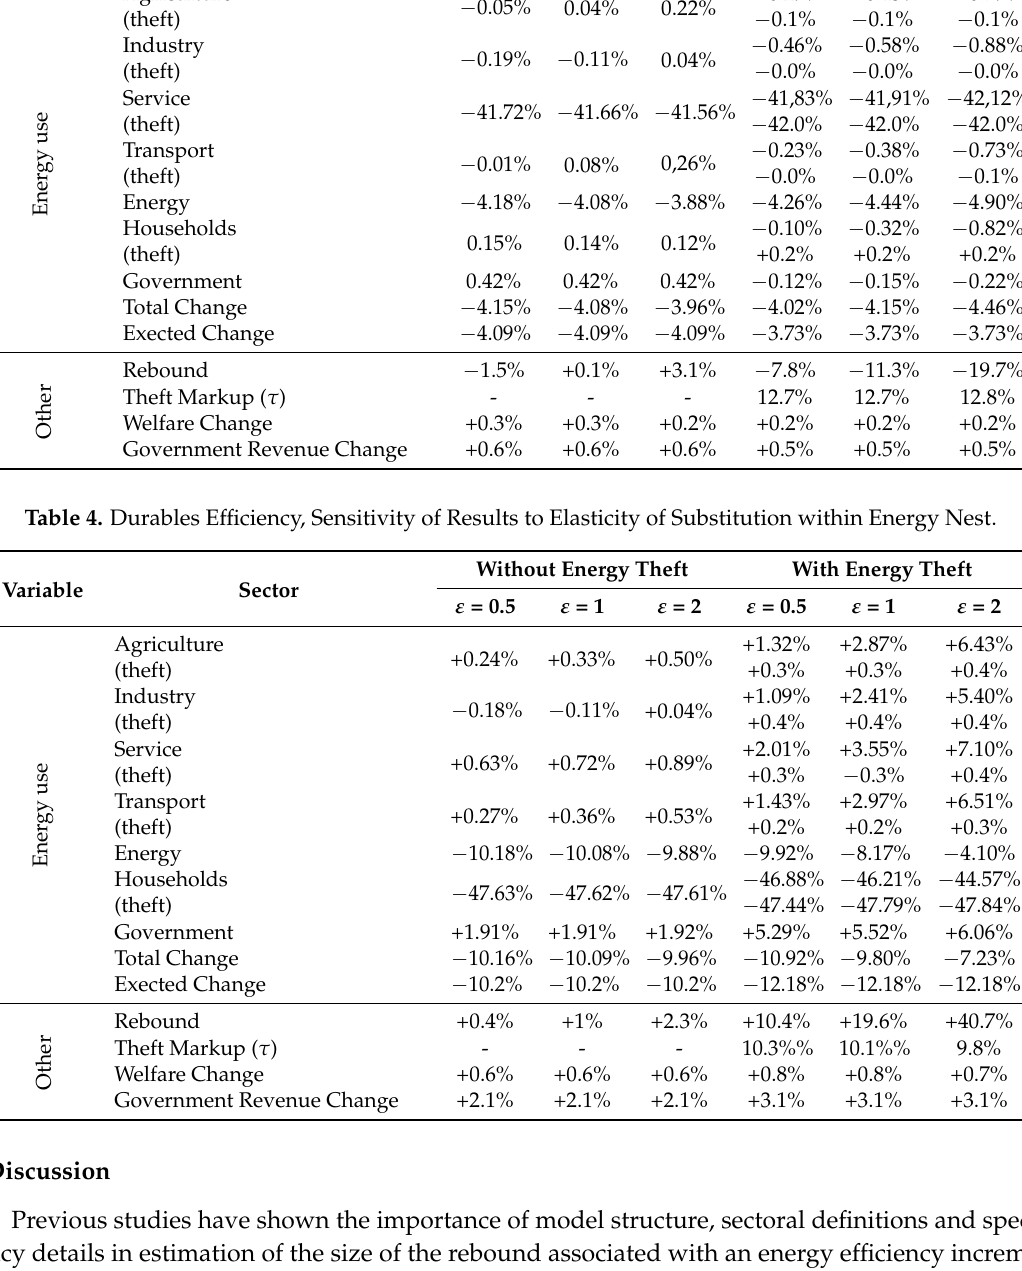
Table 3. Building Efficiency, Sensitivity of Results to Elasticity of Substitition within Energy Nest. Variable